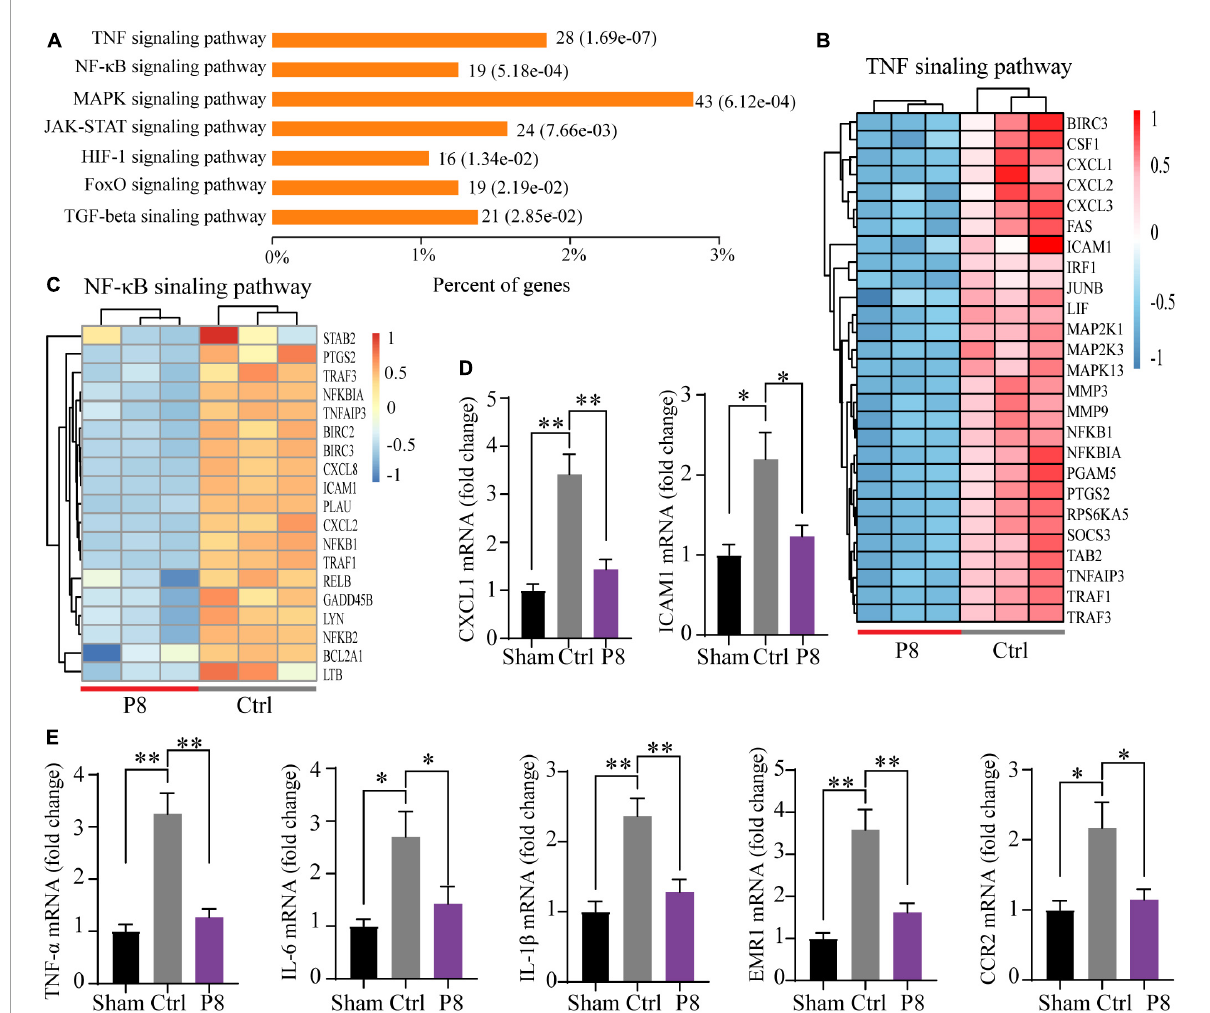
FIGURE5 P8 attenuates inflammatory response in hESC-derived cardiomyocytes subjected to hypoxia/reoxygenation injury. (A) KEGG pathway enrichment analysis of differentially expressed genes between in the P8-treated group vs. the Ctrl group of hESC-derived cardiomyocytes subjected to hypoxia in a hypoxic cell incubator for 2 h followed by 1 h of reoxygenation ( n = 3 per group). (B) Heatmap shows the selected differentially expressed transcripts (normalization with Z-score, adjusted p -value < 0.05) of TNF signaling pathway. (C) Heatmap shows the differentially expressed transcripts (normalization with Z-score, adjusted p -value < 0.05) of NF- κ B signaling pathway. (D,E) Real-time PCR analysis of the expressions of (D) inflammation-related genes (CXCL-1, ICAM1) and (E) proinflammatory molecules (TNF- α , IL-6, IL-1 β , EMR-1 and CCR1) in hESC-derived cardiomyocytes after hypoxia-reoxygenation treatment ( n = 3) cultures. * p < 0.05; ** p <